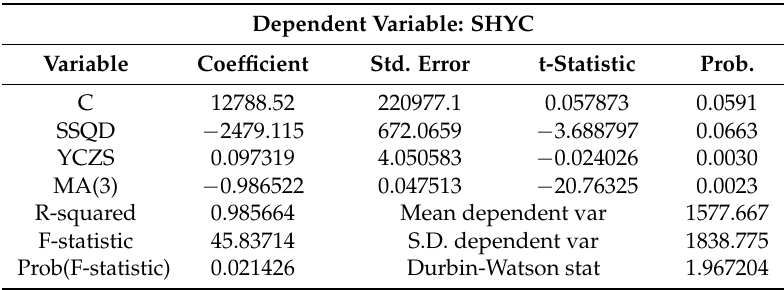
Table 10. Estimation of the fishing vessel damage equation measurement